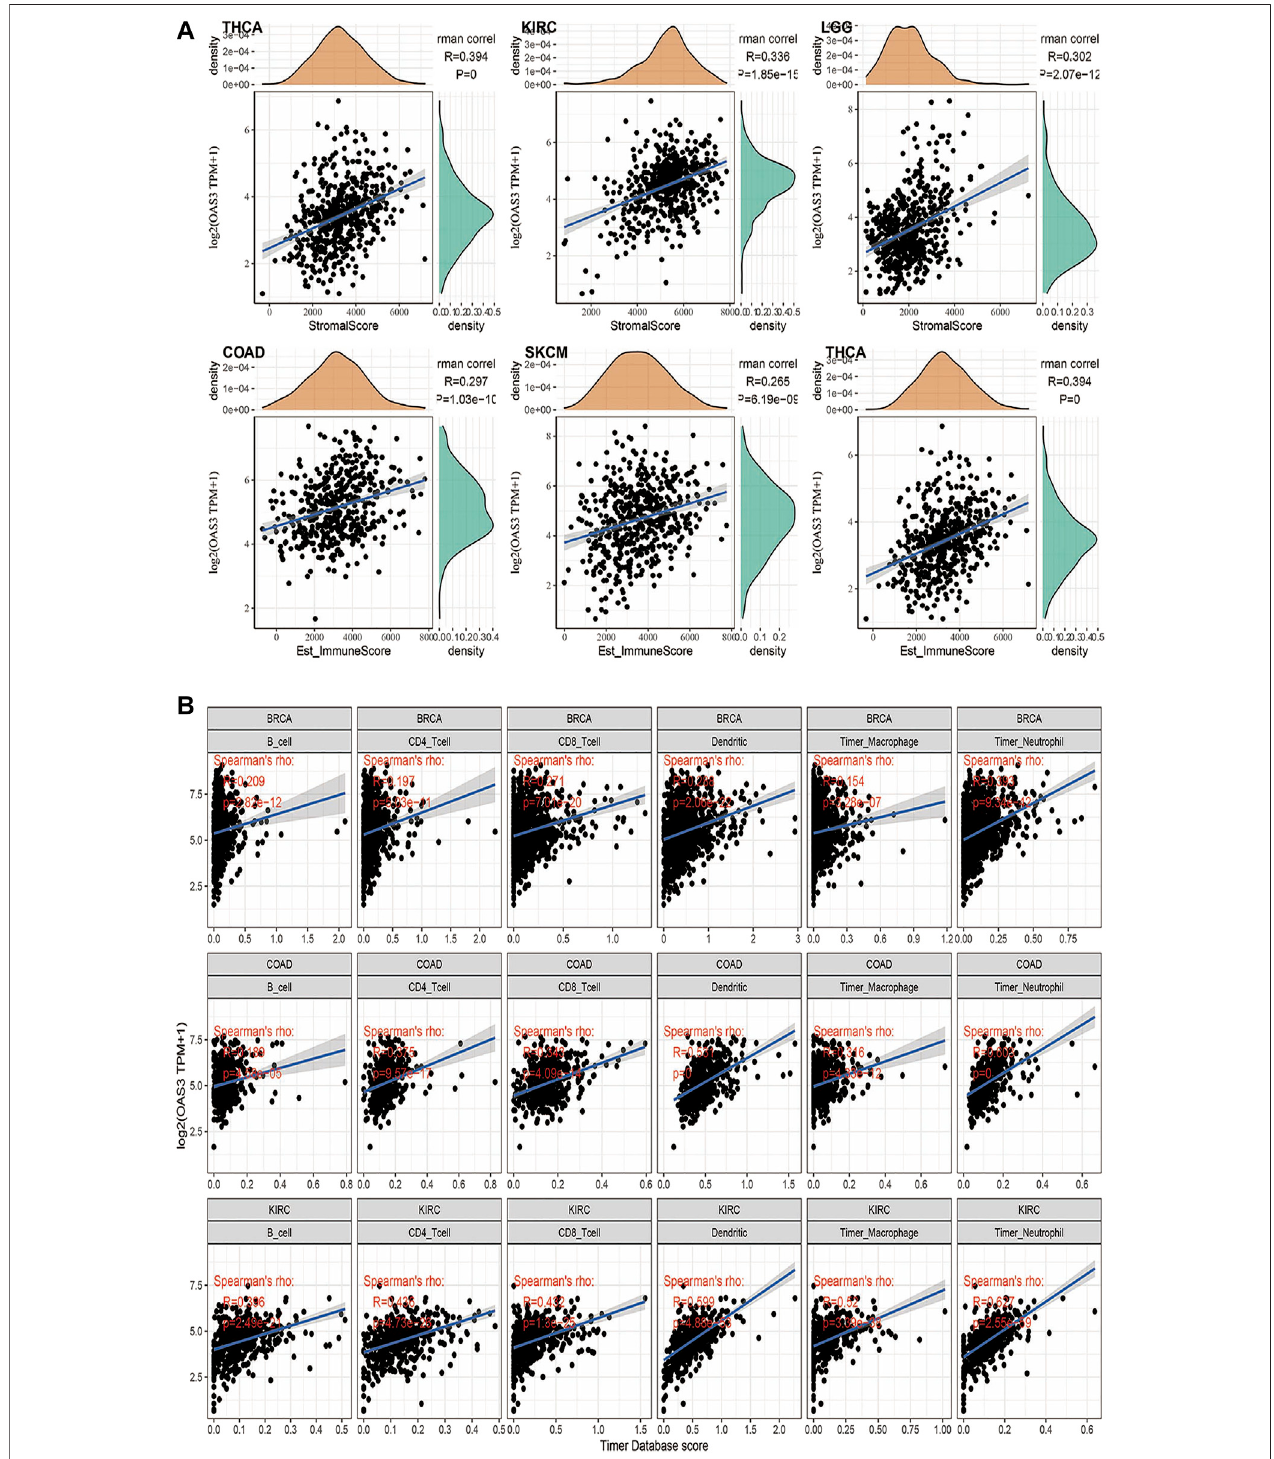
FIGURE 5 | (A) Among the 33 tumors, the top 3 tumors with the highest stromal scores were THCA, KIRC, LGG; the highest immune scores were COAD, SKCM, THCA; the highest ESTIMATEScore was COAD, SKCM,THCA. (B) TIMER analyzed relationship between OAS3 expression and the abundance of tumor-in fi ltrating immune cells in BRCA, COAD, KIRC. The results showed a positive correlation between OAS3 expression and immune cell in fi ltration.